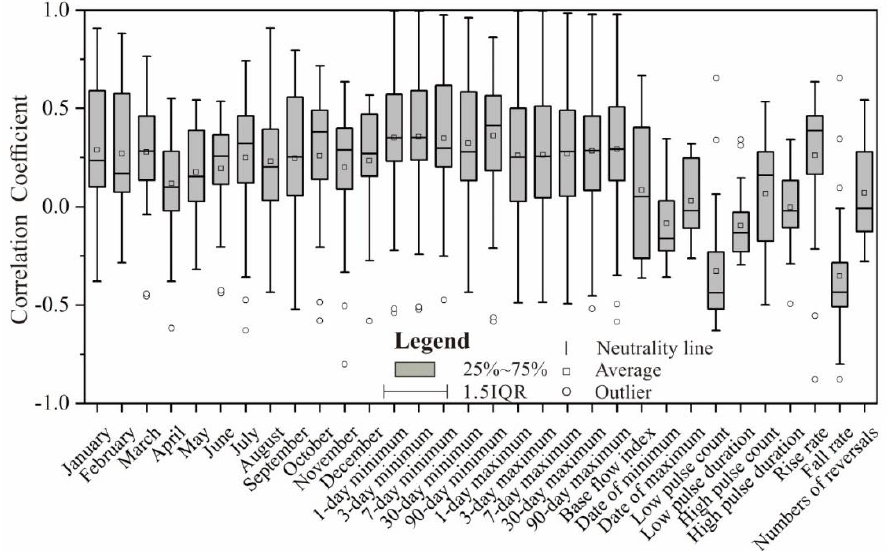
Figure 6. Boxplot of the correlation coefficients between the 32 IHAs. Table 5. ERHI results using the principal component analysis method .